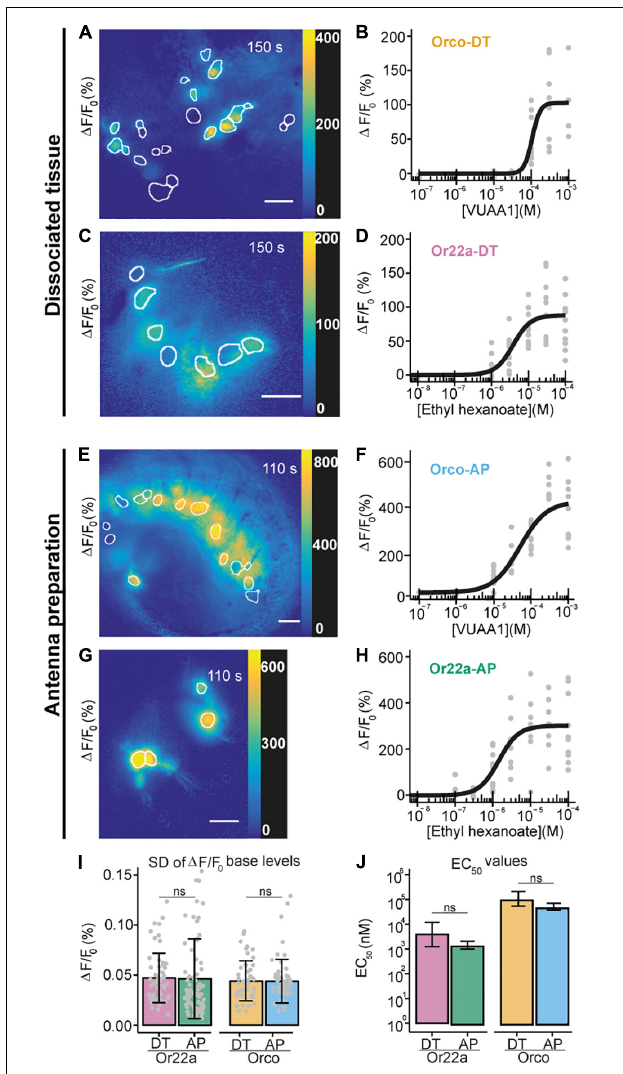
FIGURE 3 | Comparison between Ca 2 + imaging from OSNs in sodium metasilicate-embedded and undissociated antennal tissue. (A–D) (cid:49) F/F 0 (%) from antennal dissociated tissue with (A) Orco expressing neurons and (C) Or22a OSNs following the application of ethyl hexanoate (EH) and VUAA1, respectively, at dose-dependent concentration. White boundaries indicate regions of interest (ROIs) for quantitative analysis. Gray lines show the (cid:49) F/F 0 (%) of each ROI shown in the corresponding left panel; the black line represents the average taken for subsequent analysis ( n = 1). Scale bar = 8 µ m. (B,D) Concentration-response curves for Na 2 SiO 3 -embedded dissociated antennal tissue with Orco ( B , Orco-DT) and Or22a OSNs ( D , Or22a-DT) stimulated with VUAA1 (4 ≤ n ≤ 11 for each concentration, 49 total data points) and ethyl hexanoate (8 ≤ n ≤ 10 for each concentration, 60 total data points), respectively. Examples of Ca 2 + imaging from Orco (E) and Or22a-expressing (G) OSNs from undissociated antennal tissue with the ROIs highlighted in white. (F,H) Concentration-response curves from Orco (F) and Or22a-expressing OSNs (H) from undissociated antennal tissue after stimulation with increasing concentrations of VUAA1 (Orco-AP) (F) and ethyl hexanoate (Or22a-AP) (H) . 5 ≤ n ≤ 11 (F) and 6 ≤ n ≤ 11 (H) for each concentration, 60 and 71 total data points, respectively. Parameters for curve fits are reported in Supplementary Table 5 . (I,J) Comparison between the (cid:49) F/F 0 standard deviation (SD) before stimulus application (I) andthe half maximaleffective concentrations(EC 50 ) (J) ofthe OSNs fromthe